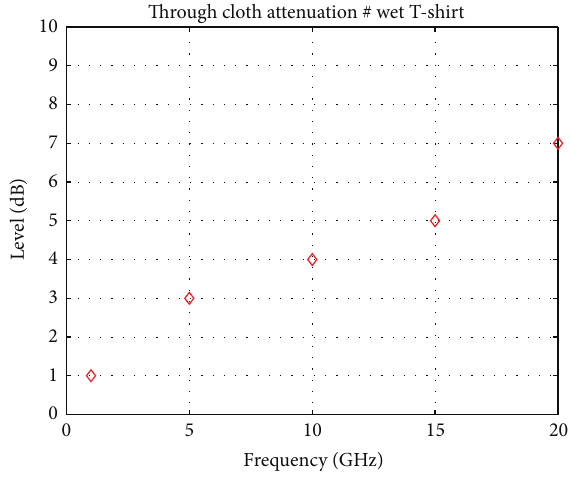
Figure 2: Attenuation versus frequency for a wet T-shirt.